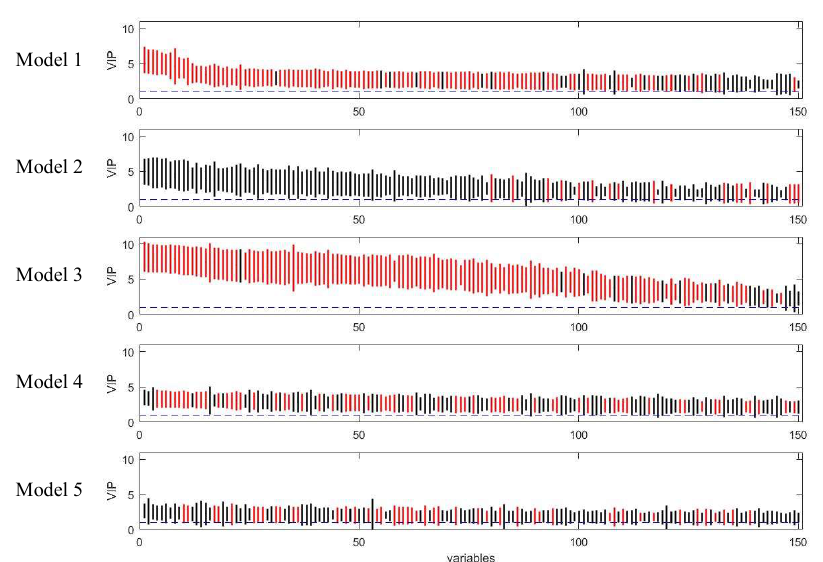
Figure 9. Rank of VIP scores for the discriminating variables in five PLS models on onion study dataset. Bootstrapped VIP scores for all the variables were ranked according to their mean VIP scores in descending order. Red and black represent the variables which are discriminating or non-discriminating, respectively. The horizontal blue dash line corresponds to VIP = 1.